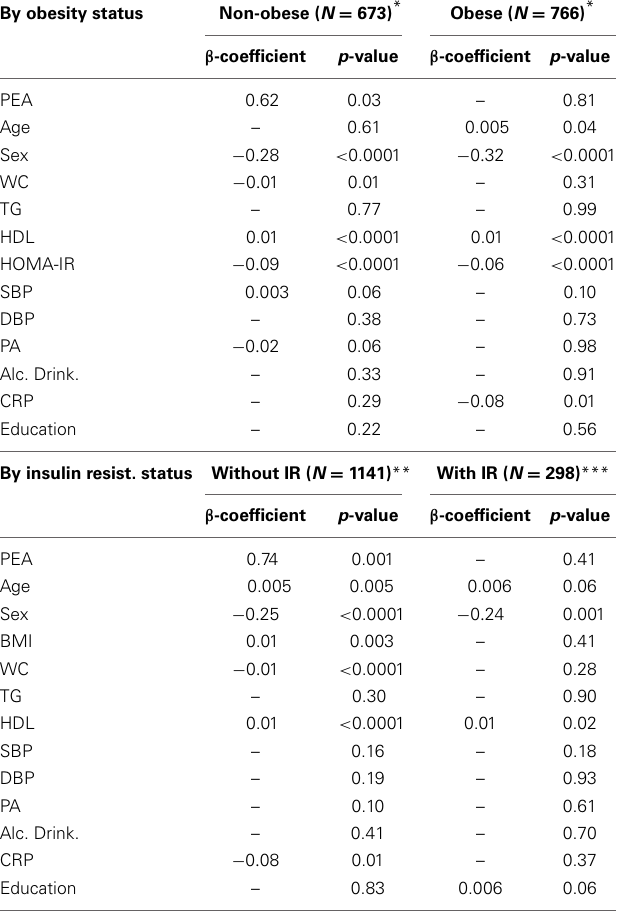
Table 2 | Age- and sex-adjusted Pearson correlation coefficients between adiponectin, proportion of European ancestry and covariates ( N = 1439).